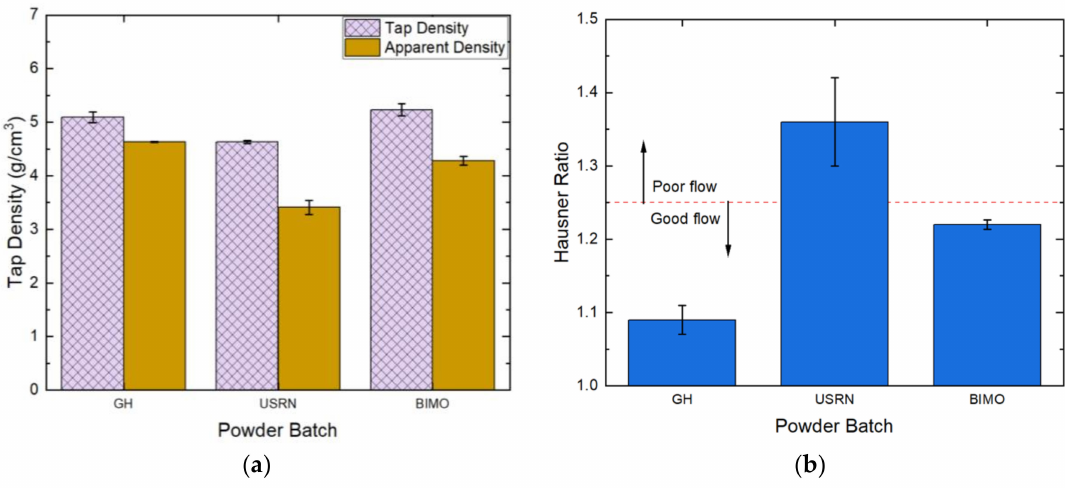
Figure 3. ( a ) Powder bed densities for each powder type; ( b ) Hausner ratio measured for each powder type. The red dotted line shows upper limit of good flow at H <